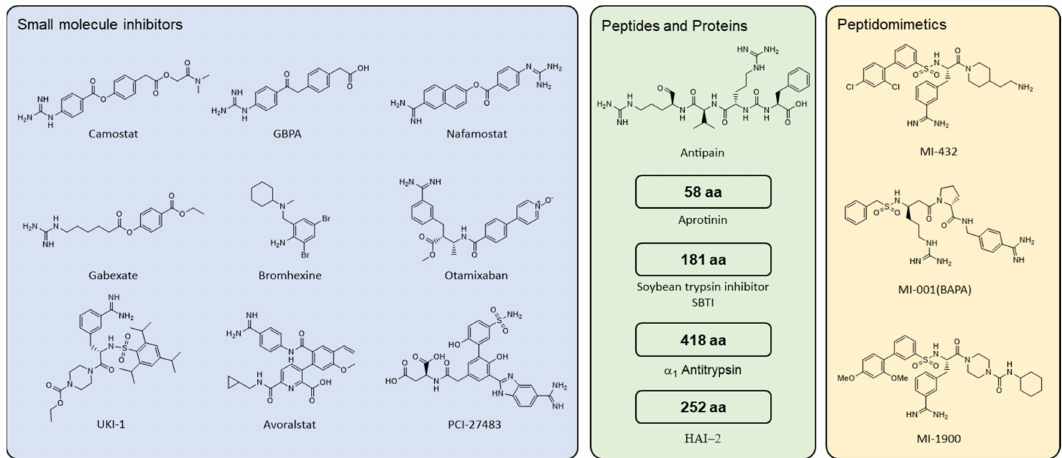
Figure 4. Overview of inhibitors of TMPRSS2 protease